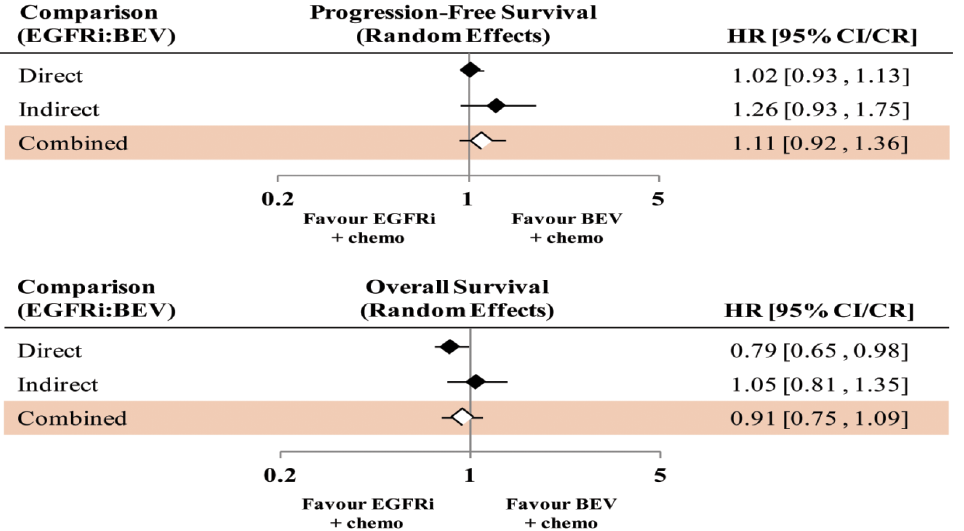
Fig 5. Forest plots showing hazard ratios calculated from direct, indirect and combined analysis of EGFRis versus BEV regimens. For direct comparisons a CI was calculated, and for indirect and combined comparisons, a CR was calculated.